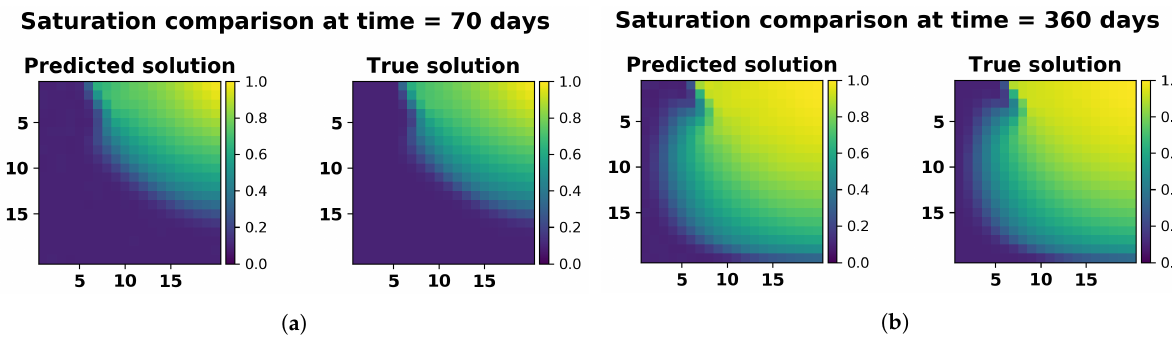
Figure 15. Saturation solution comparison at ( a ) Time = 70 days and ( b ) Time = 360 days.